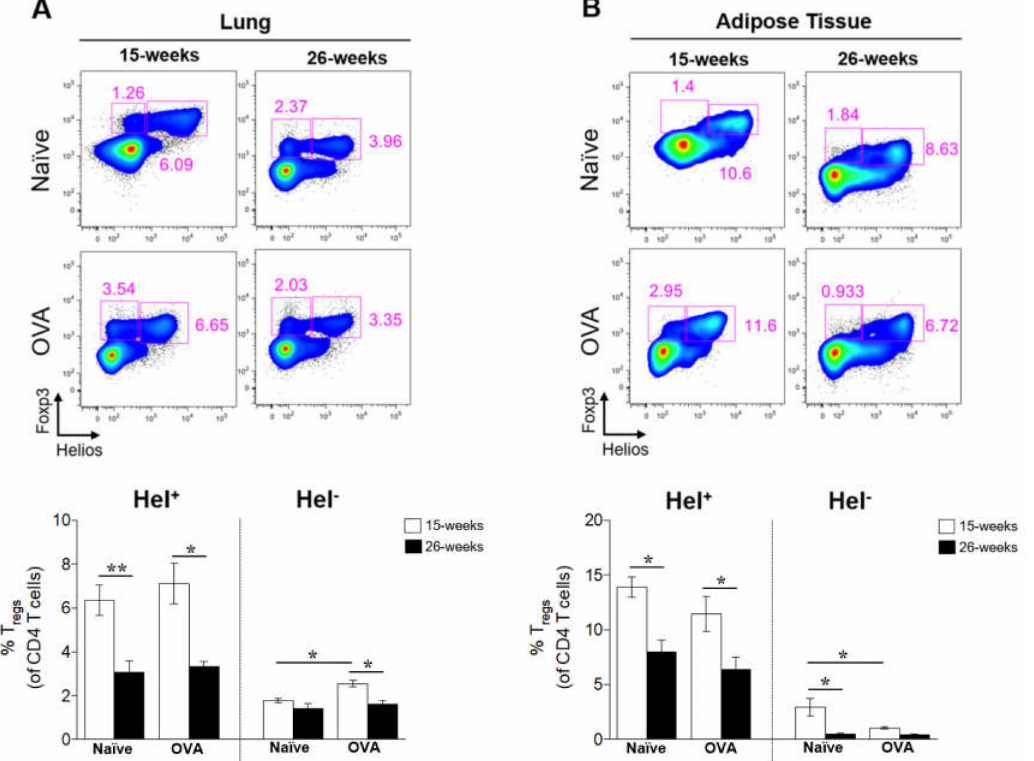
Figure 5. Lung and adipose tissue Helios + and Helios − Foxp3 + Tregs in the DIO-associated allergic inflammation model. ( A ) Representative plots show Helios and Foxp3 expression in lung CD4 T cells (upper). The percentages of lung Helios + and Helios − cells within CD4 T cells in naïve and allergic DIO mice on HFD at 15 weeks (overweight) and 26 weeks (morbid obesity) of age (bottom). ( B ) Representative plots show the Helios and Foxp3 expression in adipose tissue CD4 T cells (upper). The percentages of adipose tissue Helios + and Helios − cells within CD4 T cells in naïve and allergic DIO mice (bottom). Subsets of Tregs are showed as CD3 + CD4 + Foxp3 + Helios + or CD3 + CD4 + Foxp3 + Helios − cells. Data are means ± SEM of n = 3–4 mice per group. One-way ANOVA followed by Bonferroni’s multiple comparisons test, * p < 0.05, and ** p < 0.01. DIO, diet-induced obesity; HFD, high-fat diet; OVA, ovalbumin; AdipoR1, adiponectin receptor 1; Tregs, regulatory T cells; and Hel,